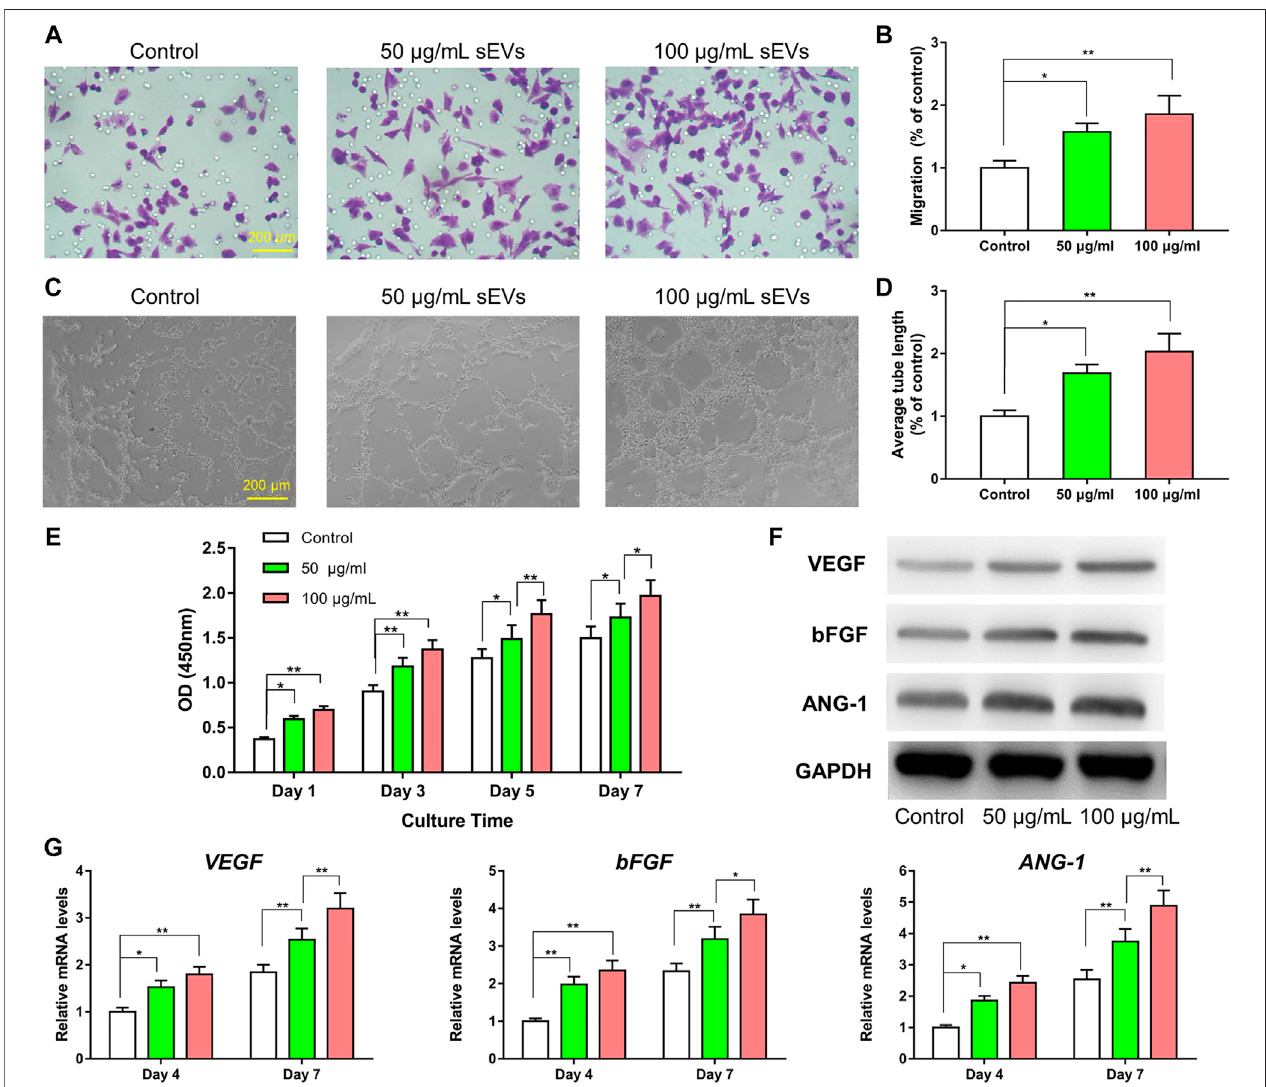
FIGURE 3 | Enhanced angiogenic effect ofsEVs in vitro (*) p < 0.05 (**) p < 0.01 (A) Transwellassay and quantitative analysis (B) of the cell migration rate (C) Tube formation by HUVECs and quantitative analysis (D) of the average tube length (E) CCK8 assay for the proliferation of HUVECs exposed to different treatments (F) Western blotting assay for the protein expression of VEGF, bFGF, and ANG-1 (G) mRNA level of pro-angiogenic-related genes ( VEGF , bFGF , and ANG-1 ).